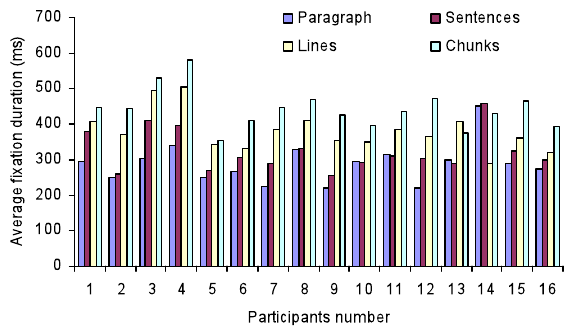
Figure 2: Average fixation duration for each participant with the various presentation formats (automatic pacing).